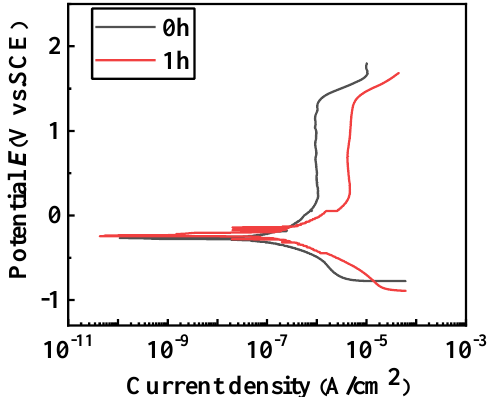
Figure 5. Potentiodynamic polarization curves of TC4 alloy before and after hydrogen charging for 1 h in 3.5 wt.% NaCl solution.